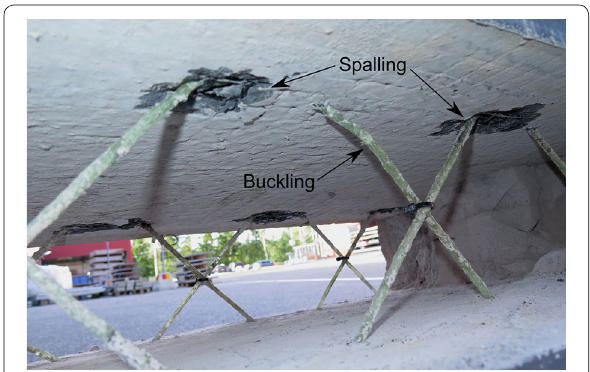
Fig. 15 Example of typical cover spalling at connector bars in tension and buckling of compressed connector